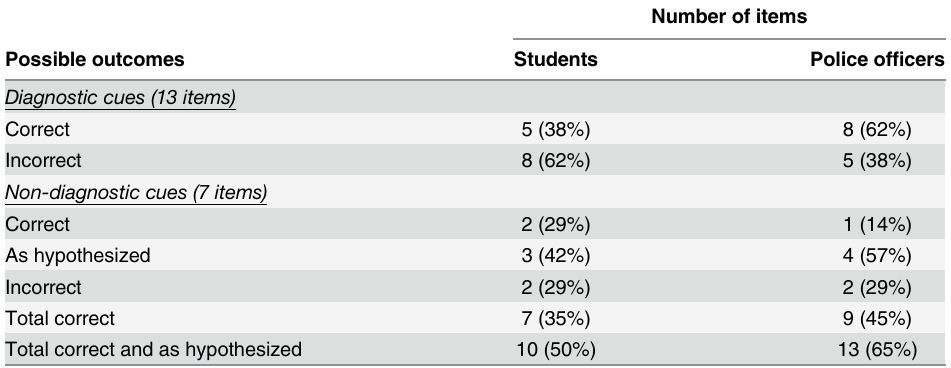
Table 5. Detailed overview of the empirical merits of the beliefs of students (n = 104) and police offi- cers (n = 95).